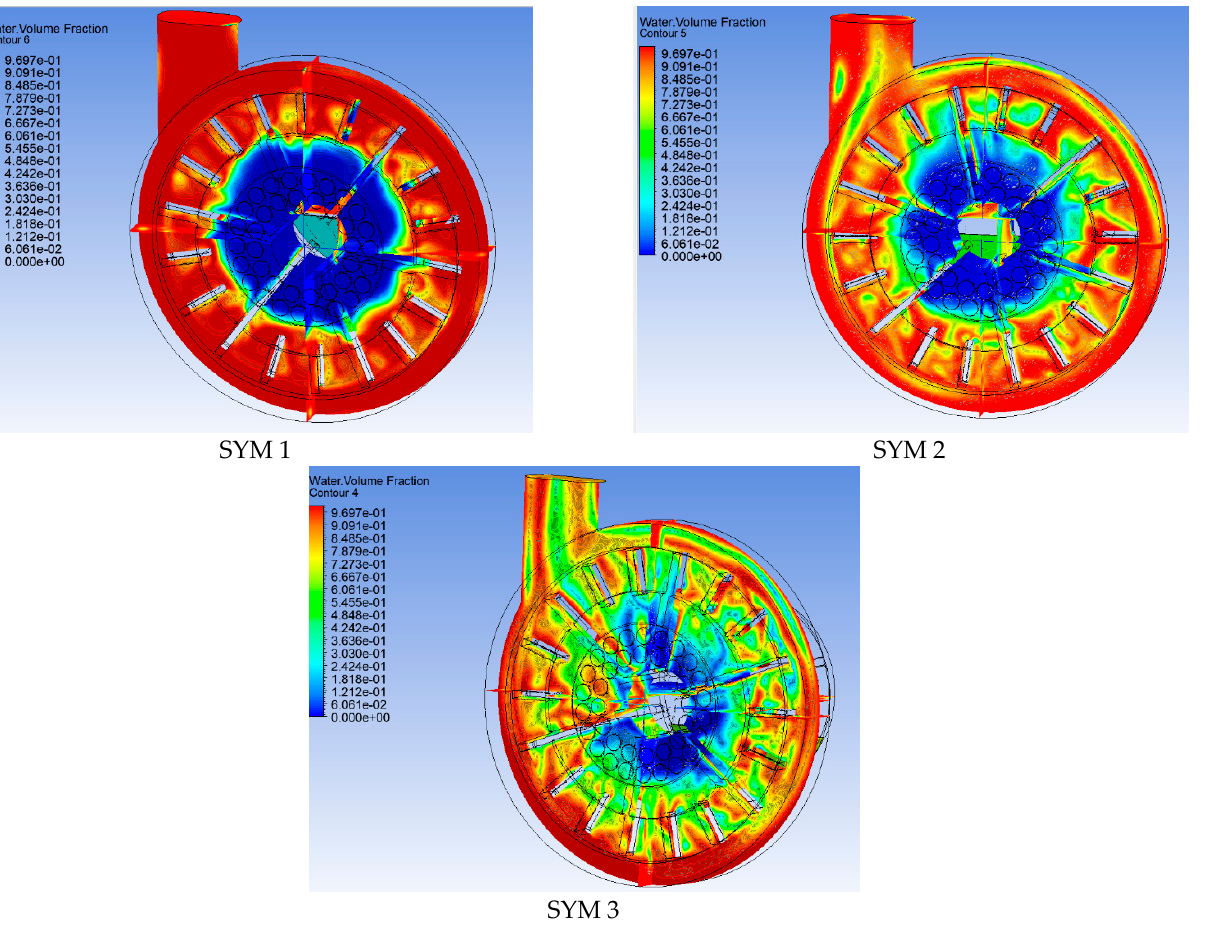
Figure 12. View from the separating disc of the pump chamber; ( SYM 1 ), ( SYM 2 ), ( SYM 3 ). Figure 13 shows the phase patterns in the water ring and low ‐ pressure zone. The zones of phase changes are marked with colors: red is 100% liquid, blue is 100% air.